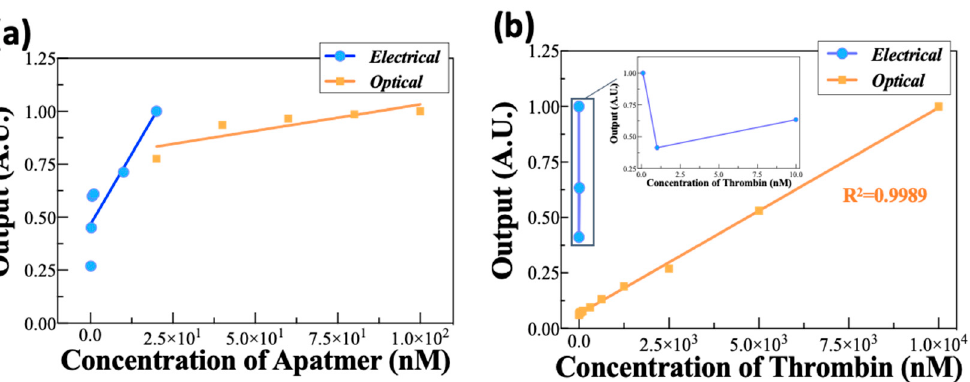
Figure 4 Comparison of the normalized experimental data using electrical and optical analysis. ( a , b ) were normalized according to the concentrations of aptamer and thrombin,